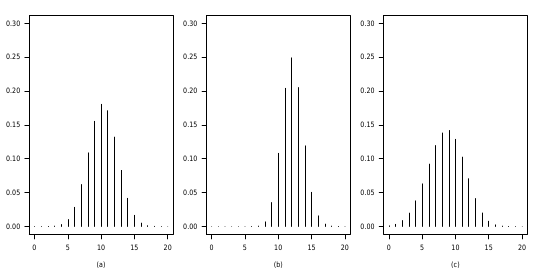
Figure 9 – An original hypergeometric distribution { p and θ = 0.51, and power hypergeometric distributions { r and α = 3.15, in panel (b), and for M = 350, m = 20, θ = 0.51, and α = 0.47, in panel (c).